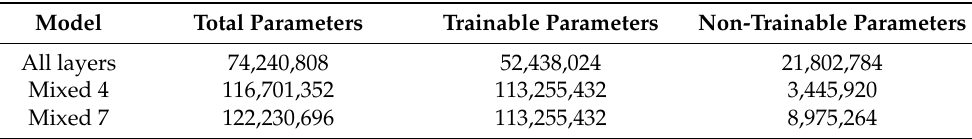
Table 6. Number of parameters in all three Inception-v3 based